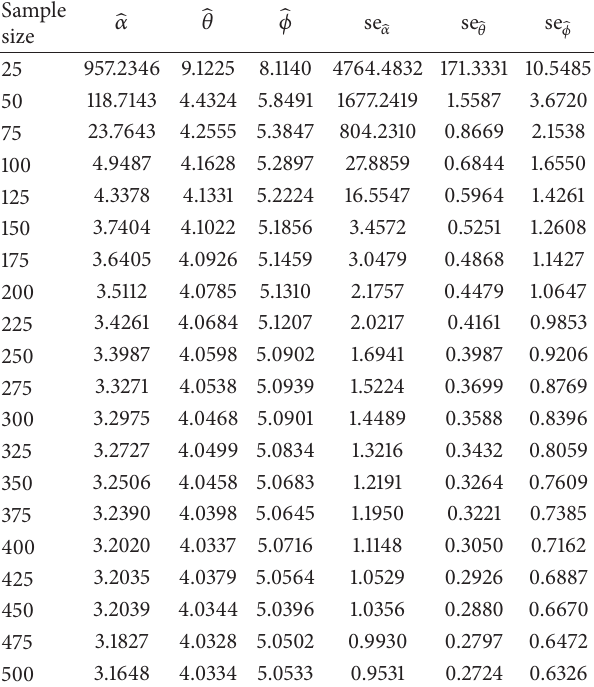
Table 5: Monte-Carlo simulation results of the parameter estimates and standard errors of the EG type-2 distribution with parameters: 𝛼 = 3.00 , 𝜃 = 4.00 , and 𝜙 = 5.00 for different sample sizes.